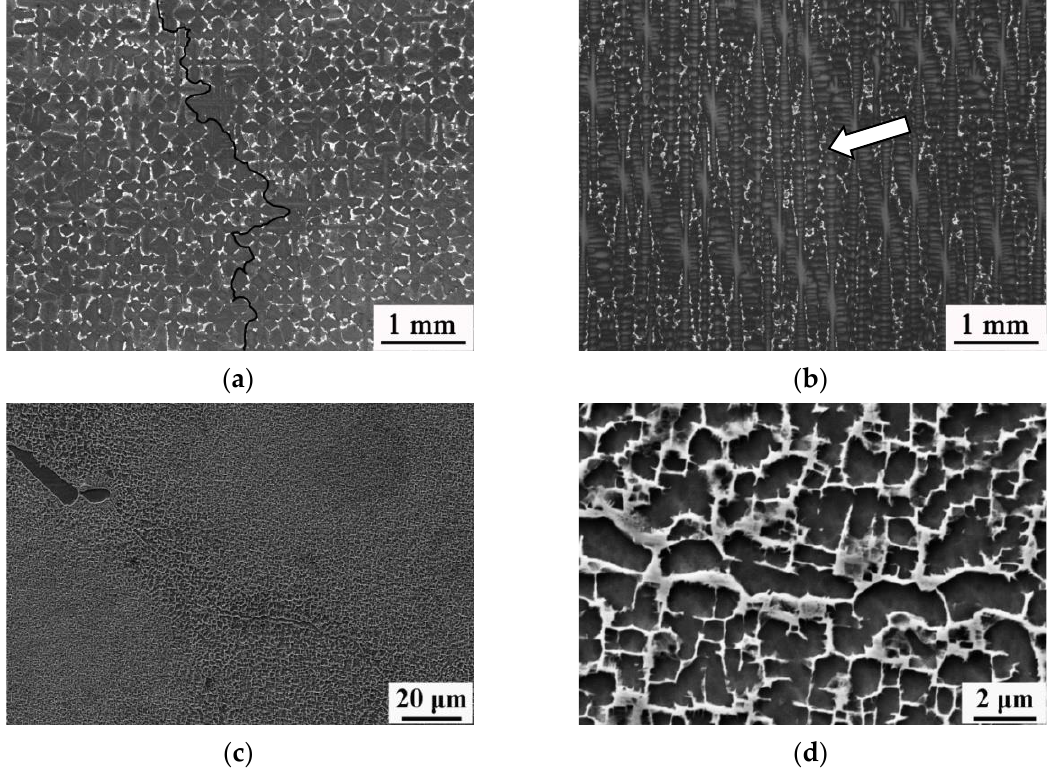
Figure 2. Microstructures of LABs of 3.7° in the as-cast DD9 alloy: ( a ) transverse dendrite morphologies; ( b ) longitudinal dendrite morphologies; ( c ) ( d ) γ’ phases morphologies.